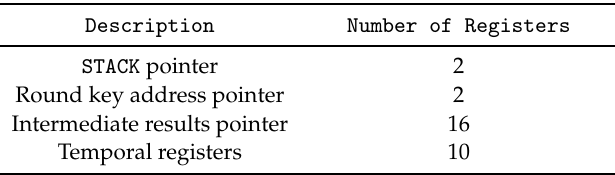
Table 2. Register utilization for key